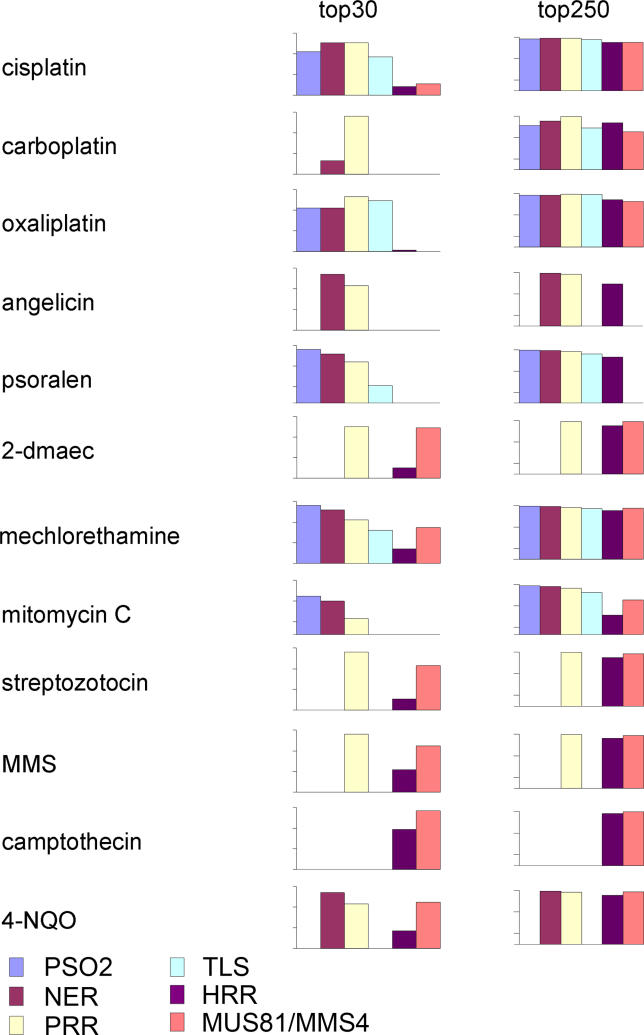
The Relative Importance of Well-Characterized DDR Modules for Resistance to Different DNA-Damaging AgentsDetailed examination of strains with mutations in DNA-damage-response genes. Each bar graph represents only strains that were found to be among the top 30 (or 250) most sensitive strains in that compound and are known to be members of a well-characterized DNA-damage-response pathway. The bars represent the median rank for genes in each of the gene groups listed in the visual key. The gene groups were defined in the following way: x-linking genes (PSO2); NER (RAD2, RAD4, RAD10, RAD1, and RAD14); PRR (RAD6, RAD18, and RAD5); error-prone TLS (REV1, REV3, and REV7); HRR (RAD57, RAD55, RAD51, RAD52, RAD54, and RAD59); stalled replication-fork repair (MUS81 and MMS4). Those compounds that form ICLs are labeled with an asterisk.